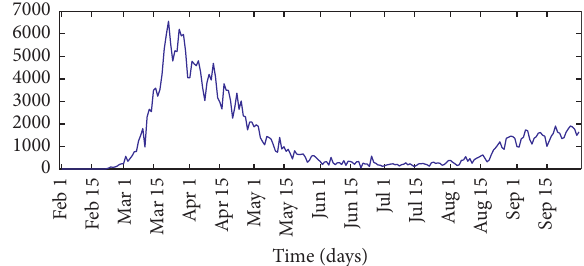
Figure 2: Daily reported COVID-19 cases from 31 st January 2020 to 29 th September 2020, Italy (source: Worldometer).